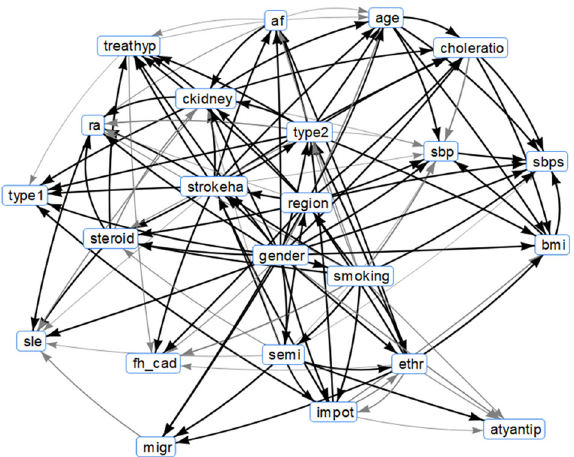
Fig. 1 Resultant graph structure for BNs learnt from samples of ground truth data. Con fi dences of 100% are represented by black arcs while those <100% are represented by varying widths in